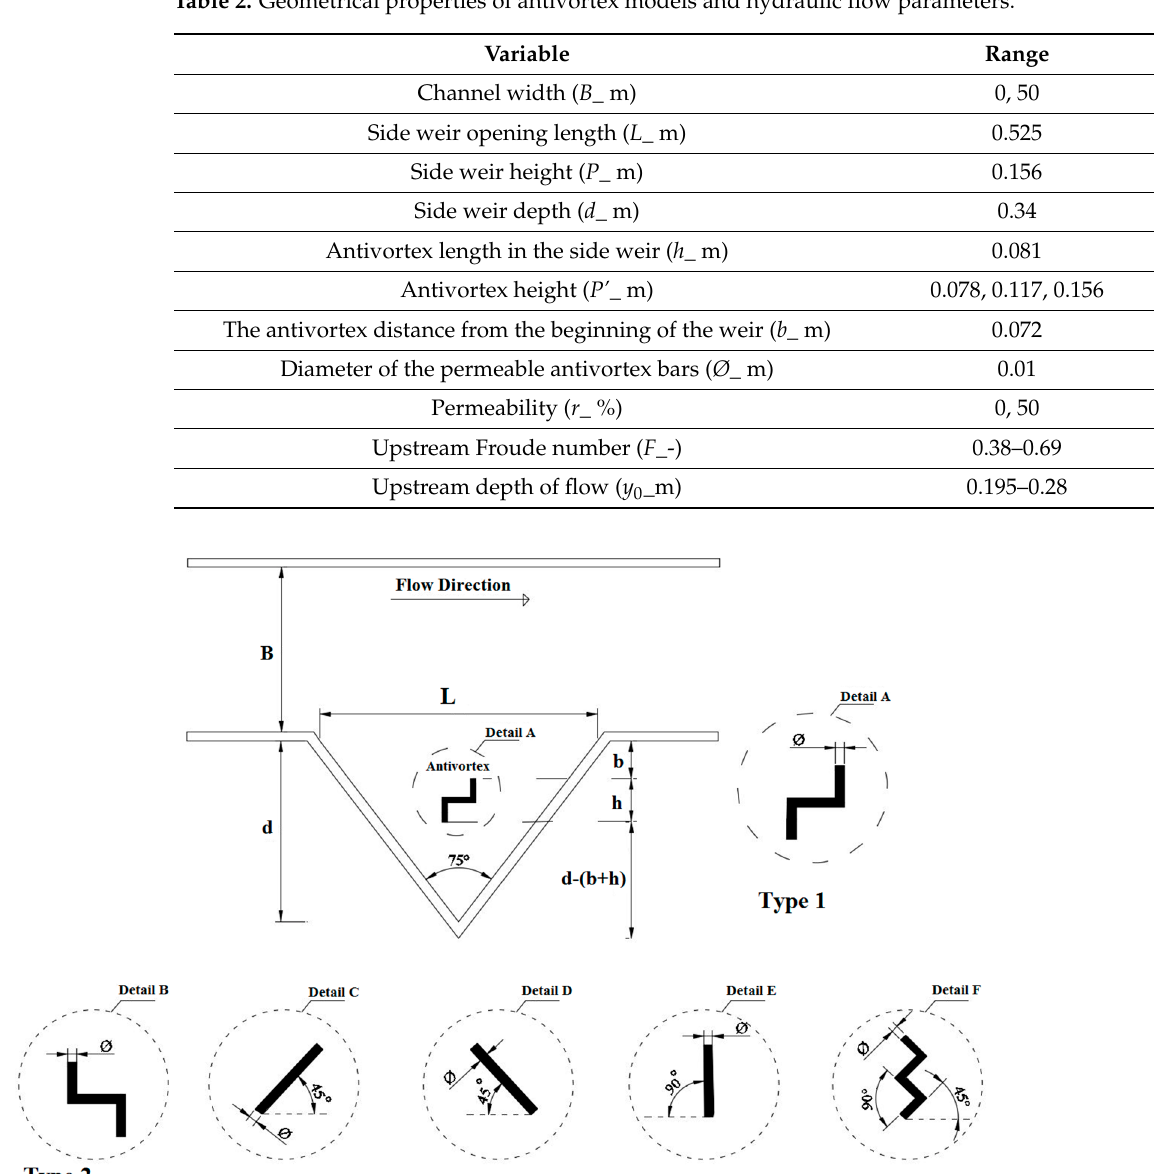
Table 2. Geometrical properties of antivortex models and hydraulic flow parameters.